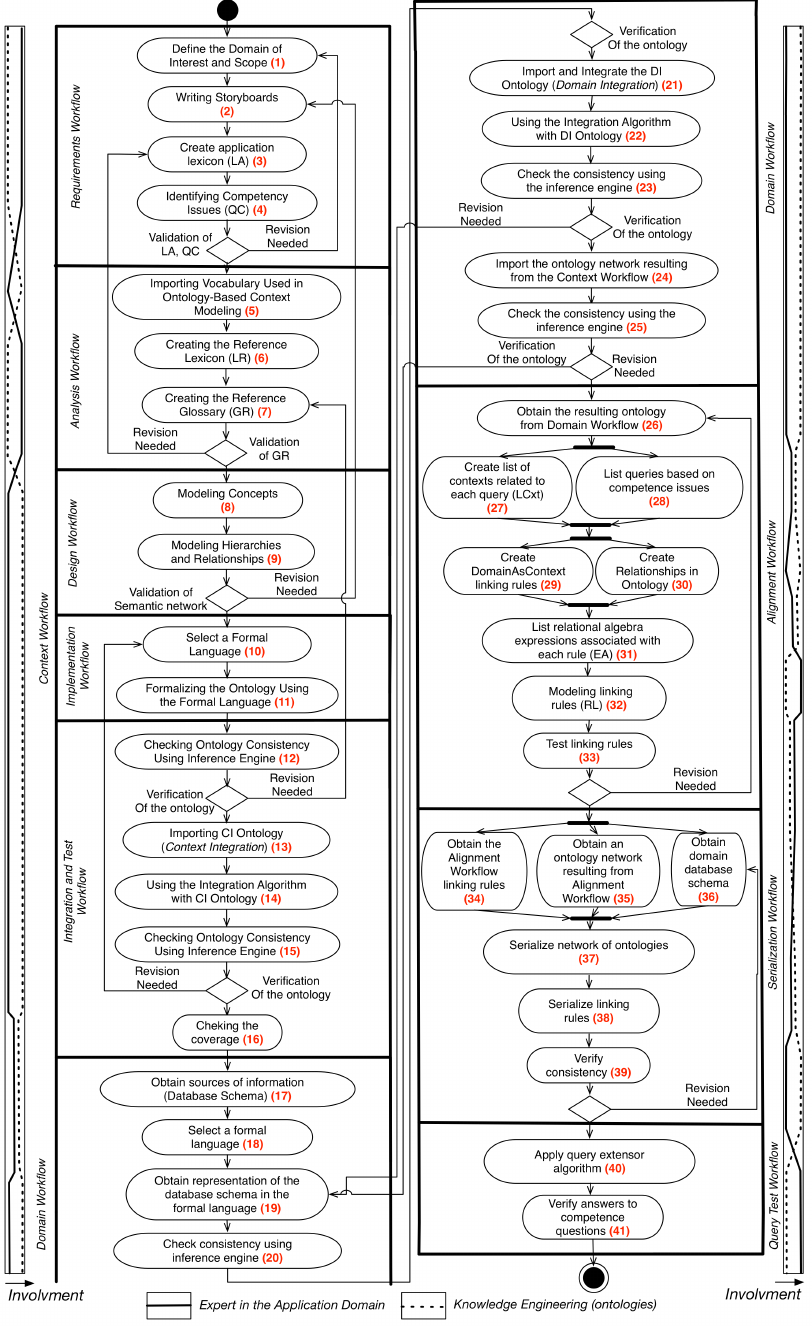
Figure 10. All process that composes the Unified Process for Integration between Context-Awareness and Domain (UPcad)